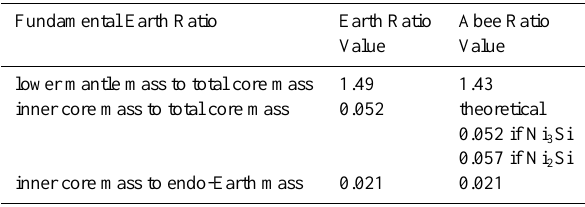
Table 1. Fundamental mass ratio comparison between the endo- Earth (lower mantle plus core) and the Abee enstatite chondrite.